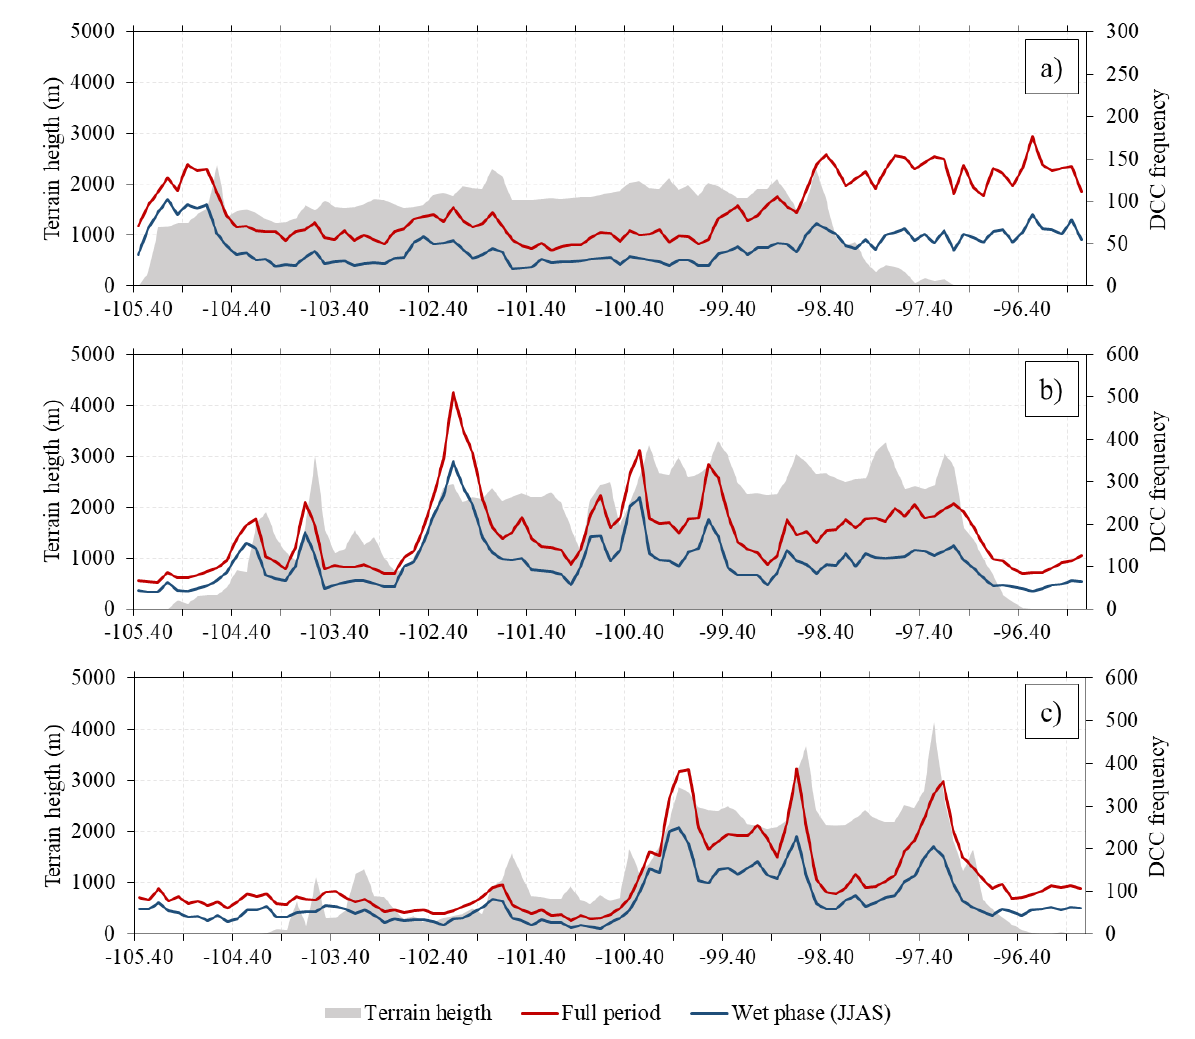
Figure 7. Cross-section at constant latitudes ( a ) 20.5, ( b ) 19.5, and ( c ) 19.0 degrees north of deep convective cloud frequency. The red line represents the total number of observed DCCs (2008–2017) and the blue line the corresponding values for the wet phase only (June, July, August, and September) based on MODIS data with a horizontal resolution of 0.1 degrees. The grey area shows the terrain height in